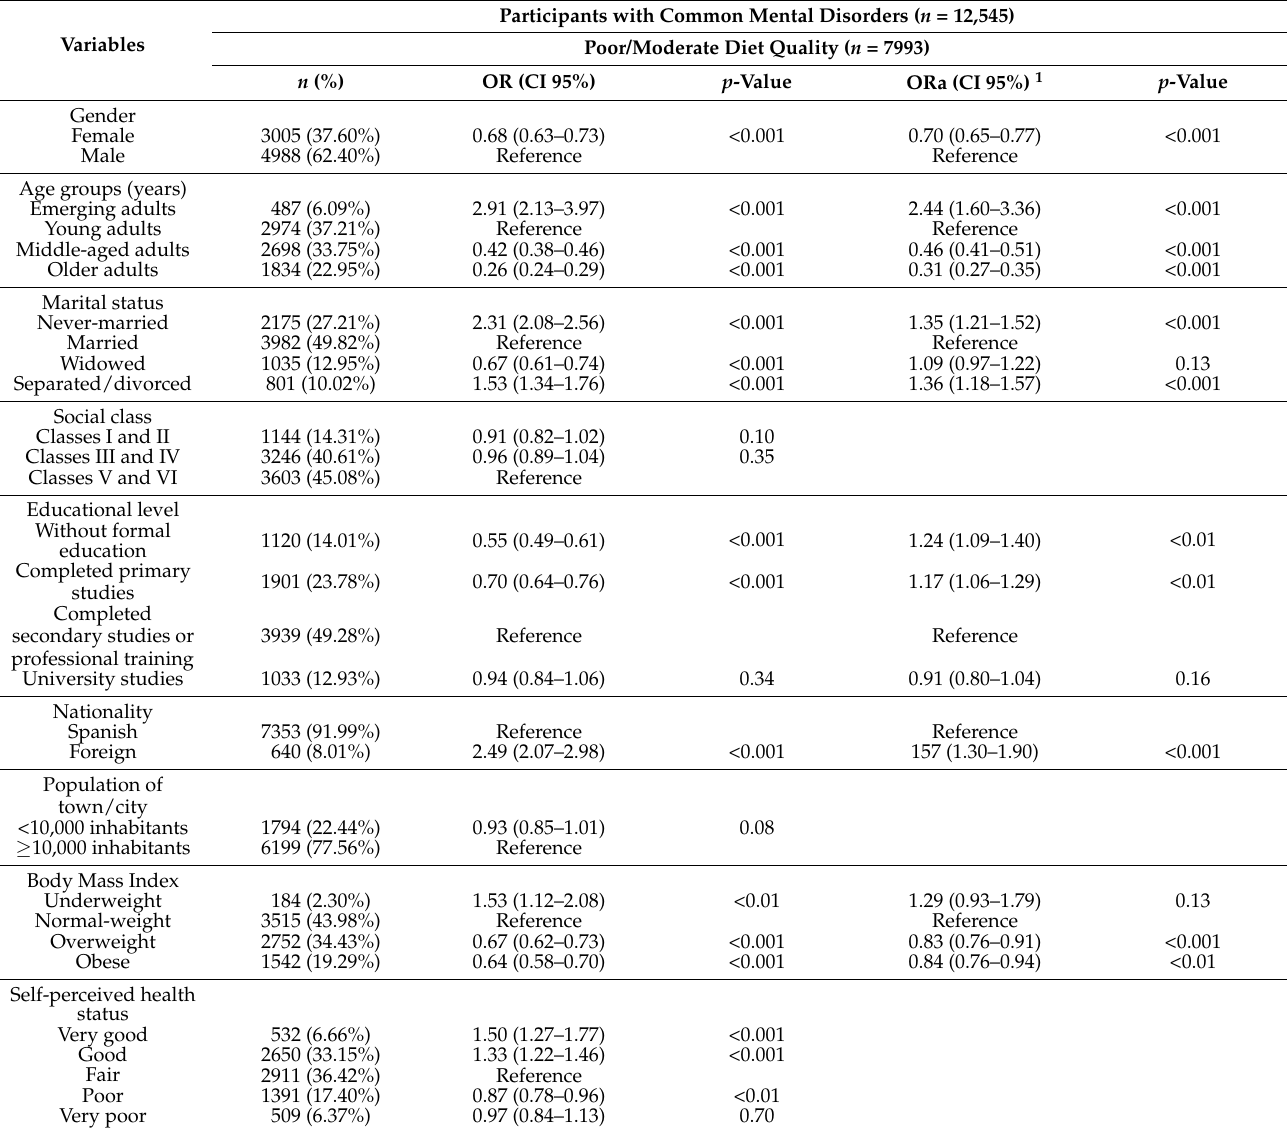
Table 5. Association between diet quality and sociodemographic, lifestyle and health-related factors in people with common mental disorders ( n = 12,545) (SNHS 2006, SNHS 2011/2012 and SNHS 2017). Participants with Common Mental Disorders ( n = 12,545) Variables Poor/Moderate Diet Quality ( n =